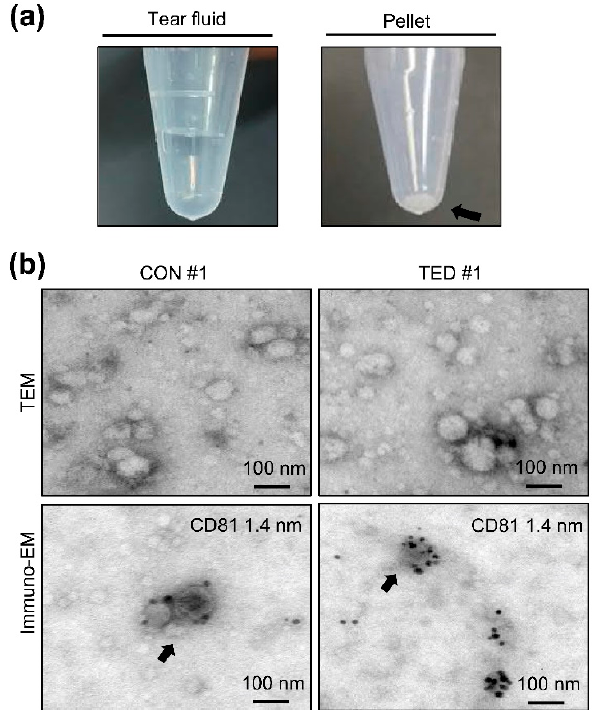
Figure 1. Isolation of exosomes from tear fluid. ( a ) Exosome pellets (black arrow) were obtained using the Exosome Plus TM method for tear fluid. ( b ) Microscopic analysis of the morphology of isolated exosomes from control subjects and TED patients, based on TEM analysis. The upper panels show negative staining with unlabeled immuno-gold particles, and the lower panels show 1.4-nM immuno-gold labeling using an anti-CD81 antibody. Scale bar, 100 nm. CON—control subject; TED—thyroid eye disease; TEM—transmission electron microscopy; immune-EM—immuno electron microscopy.